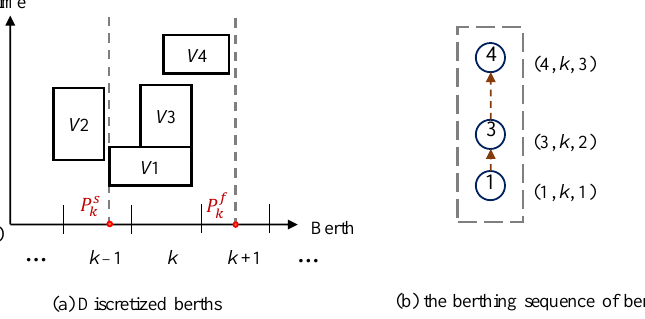
Figure 2. Diagram of discrete berths and berthing order. ( a ) Description of the discretized berths. ( b ) Description of the berthing sequence of berth k